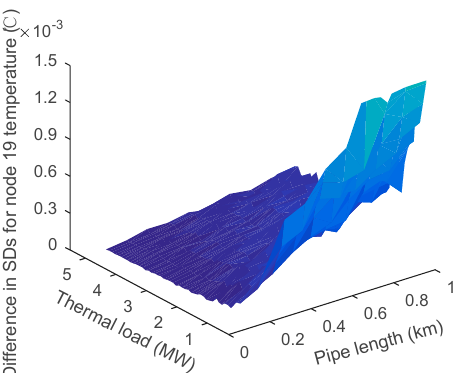
Figure 11. Relationship between the differences in the standard deviations obtained for the node temperature of node 19 using the Monte Carlo method and the proposed analytical method with respect to pipe length and average thermal load ( σ ϕ = ±10%).